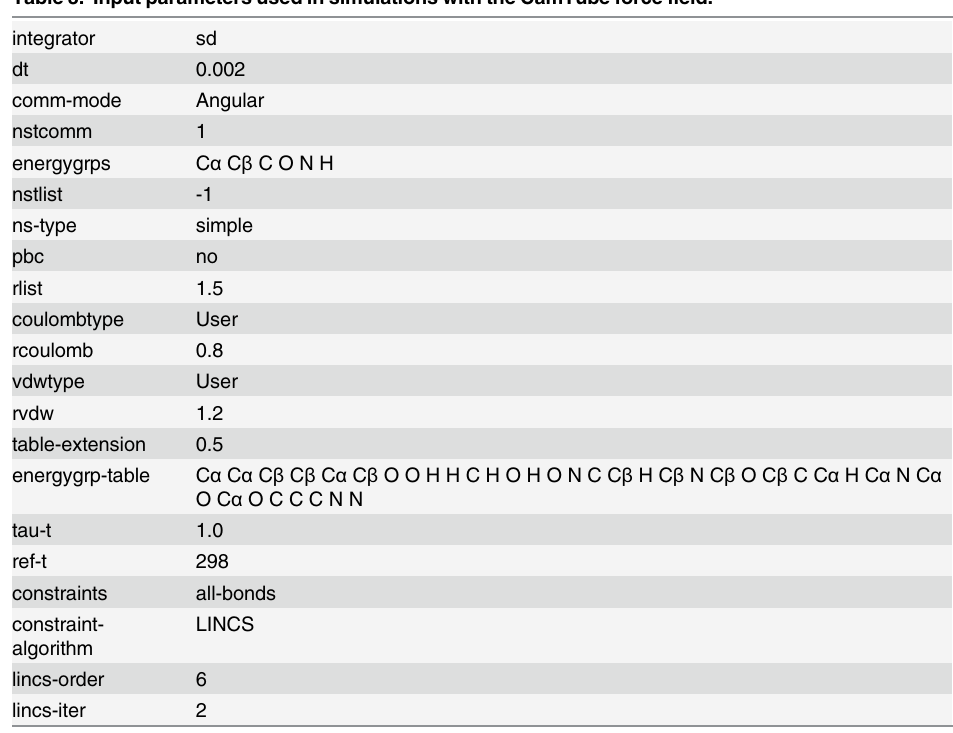
Table 3. Input parameters used in simulations with the CamTube force field.